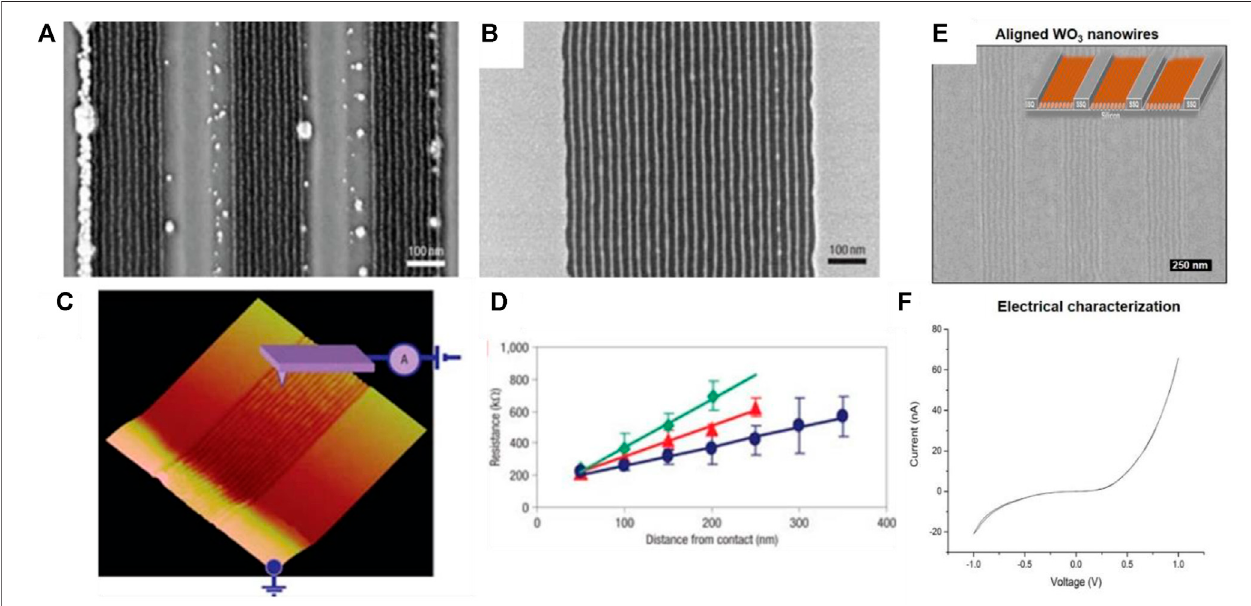
FIGURE10| SEMimagesofmetallicnanowiresalignedinsilicontrenches; (A) Aunanowiresafterexposureto10 mMHAuCl4/0.9%HF(aq.)for10 minfollowedby 30 s oxygen plasma ashing; (B) Pt nanostructures after performing LPI with 10 mM Na 2 PtCl 4 in0.9% HCl (aq.) for 3 h followed by 30 s oxygen plasma and 5 s argon plasma ashing; (C) Schematic diagram showing C-AFM for probing the electrical resistance of platinum nanowires; (D) Resistance changeas distance from the contact pads for three different platinum nanowire arrays obtained by immersion into Na 2 PtCl 4 concentrations of 0.1 mM (green), 1 mM (red) and 10 mM (blue), and their correspondingresistanceswere3.0 k Ω nm − 1 ,1.9 k Ω nm − 1 and1.2 k Ω nm − 1 ,respectively; (E) WO 3 nanowiresfollowingmetalsaltinclusionandUV/O 3 ; (F)